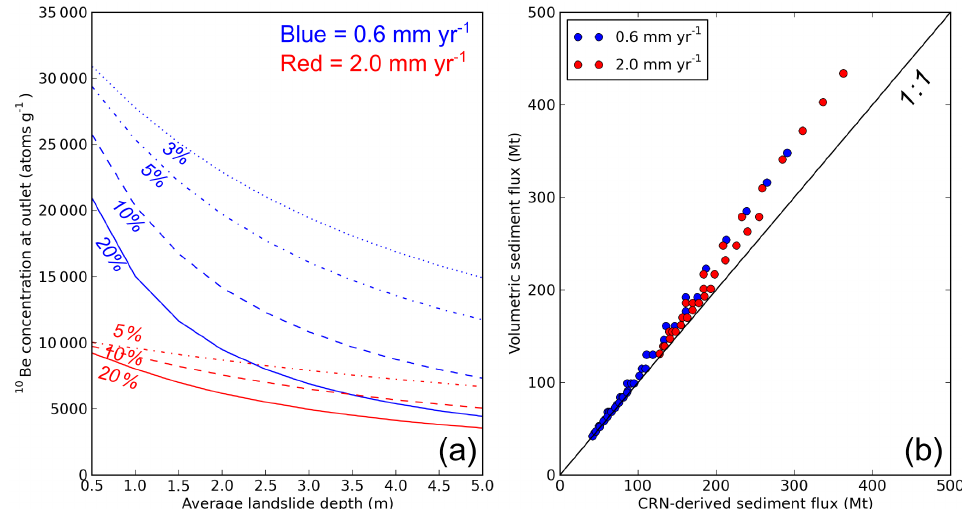
Figure 10. (a) Effect of event buffering on outlet 10 Be concentrations, where smaller fractions (3, 5, 10 and 20%) of the event sediment are mixed into the fluvial network based on two background erosion rates of 0.6 and 2.0mmyr − 1 shown in blue and red, respectively. The event proportions are represented by the different dashed lines. The average landslide surface erosion rate is set to 3.0mmyr − 1 . Under faster background erosion rates, the effect of larger landsliding events is more easily buffered in outlet 10 Be concentrations. (b) Comparison of volumetric and CRN-derived sediment fluxes for event buffering scenarios. Under these conditions, volumetric and CRN-derived sediment flux estimates are much more comparable. As the amount of landslide-derived material mixed into the system increases, volumetric sediment fluxes become slightly larger than CRN-derived sediment